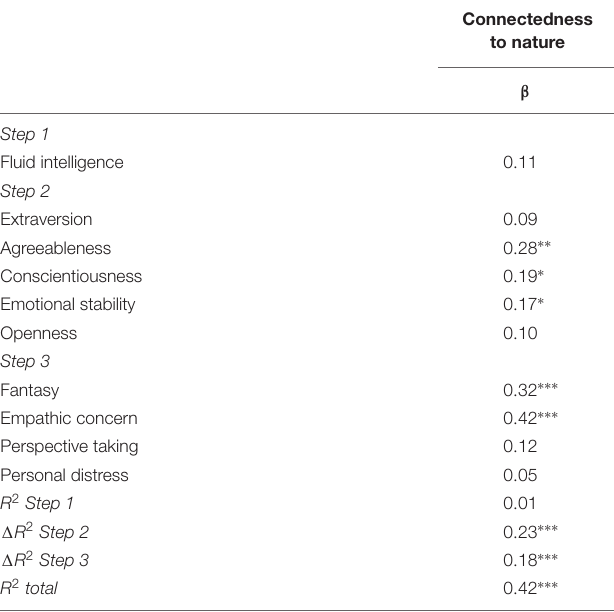
TABLE 2 | Hierarchical